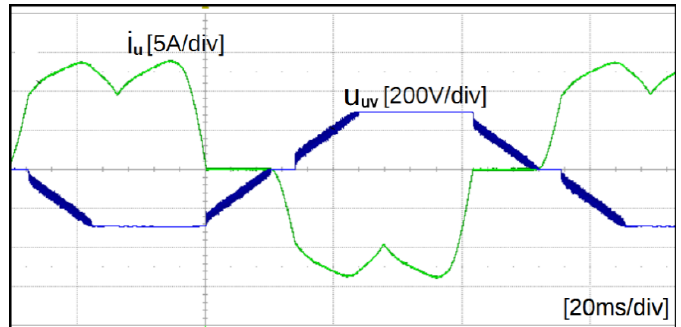
Figure 15. Waveform of the voltage and current of the generator with the diode rectifier (topology T2).